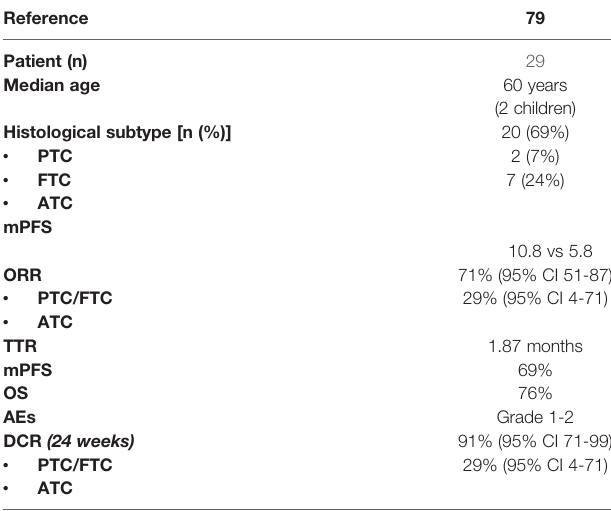
TABLE 5 | Patients main characteristics and results of pooled data from three phase I/II larotrectinib clinicaltrials(NCT02576431, NCT02122913,